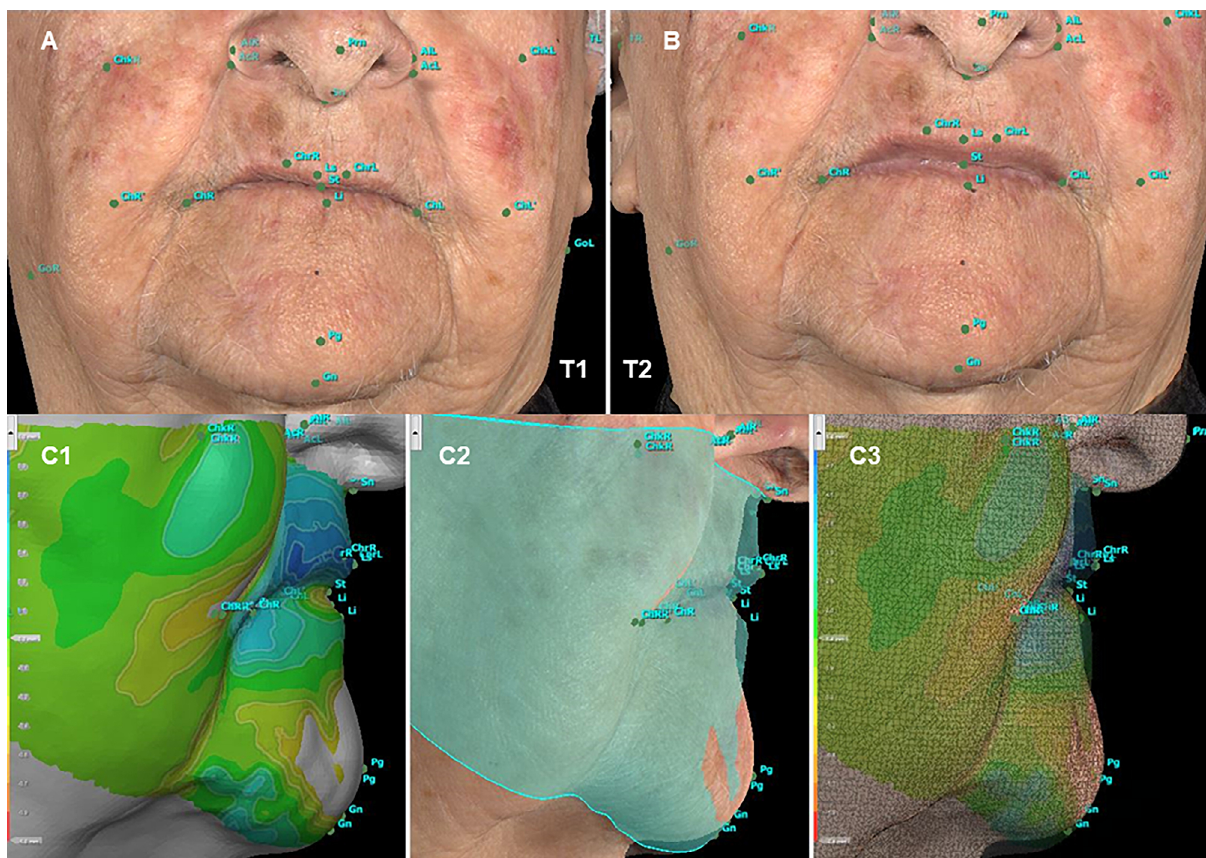
Figure 6- Facial changes between (A) T1 and (B) T2; (C1, C2, C3). Elaboration of a chromatic facial analysis with different colors (red: areas with -1 mm to 0 mm difference, green: 0 mm superimposed areas, and blue: areas with 0 to 2 mm difference) of the lower third